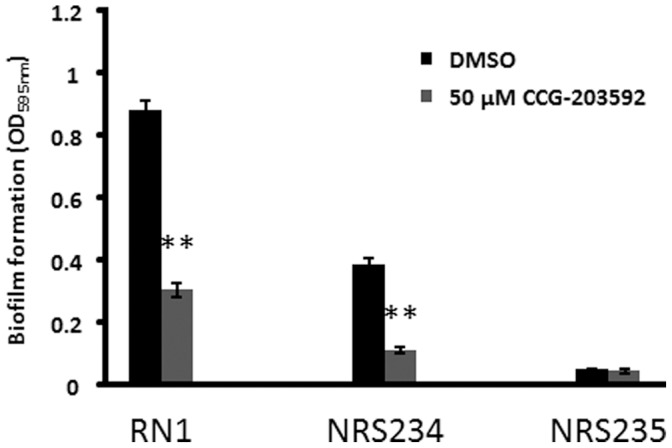
The effect of 50 µM CCG-203592 on S. aureus RN1, NRS234 and NRS235 biofilm formation. Biofilm formation was determined by OD595 nm reading of crystal violet stain solubilized by ethanol with DMSO treatment as controls. The data is presented as mean±standard error of means for a total of 9 samples (pooled from 3 independent experiments in triplicate). ** p<0.01.